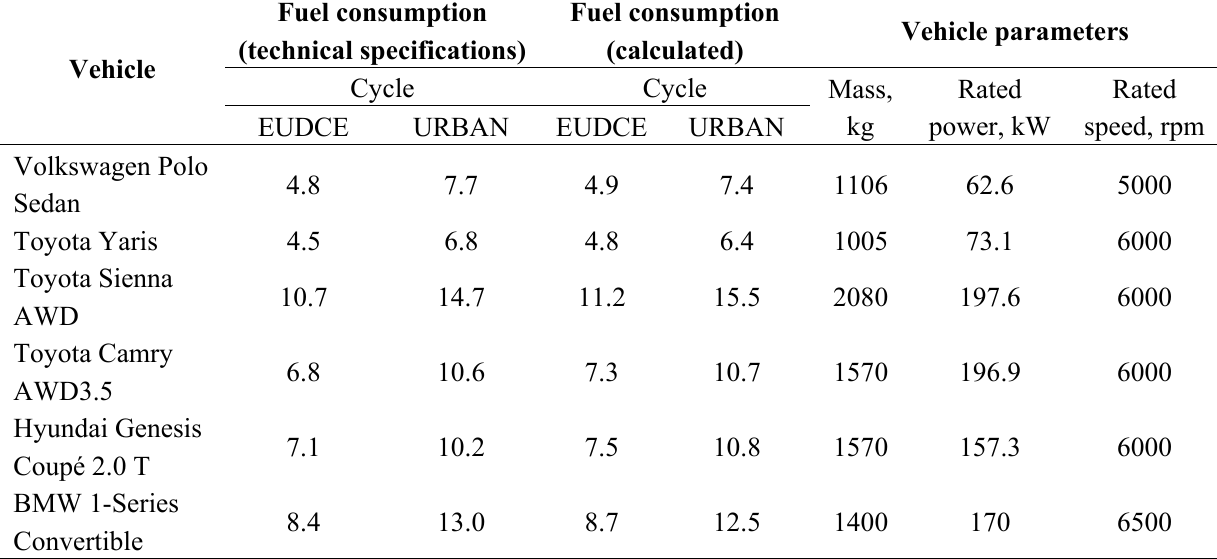
Table 3. Comparison results of vehicles fuel